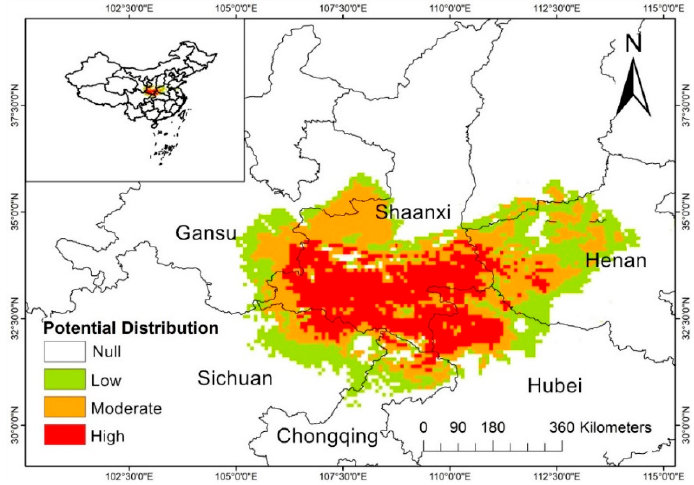
Figure 4. Potential distribution of D. armandi in China modeled with BIOCLIM. Table 7. The first four factors and coefficients of Ecogeographic Variables (EGVs) to factors generated by Ecological Niche Factor Analysis (ENFA).